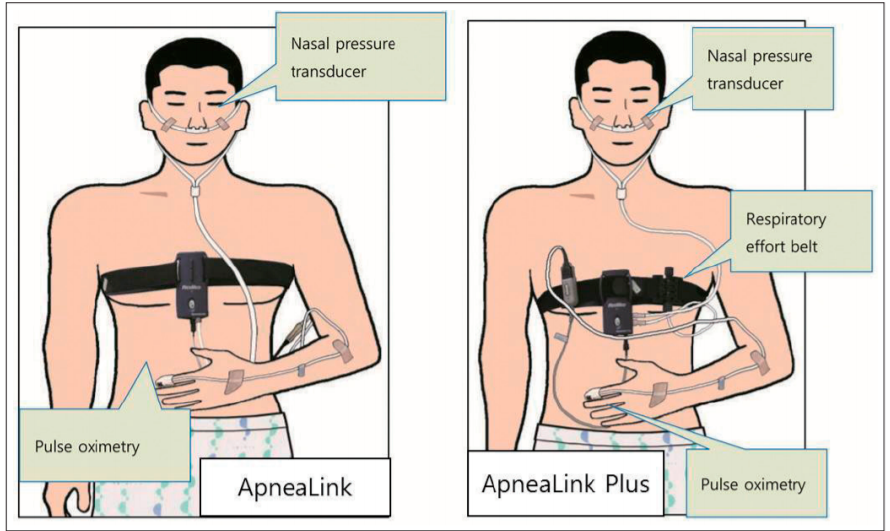
Figure 3. Portable sleep inspection devices “ApneaLink and ApneaLink Plus”.